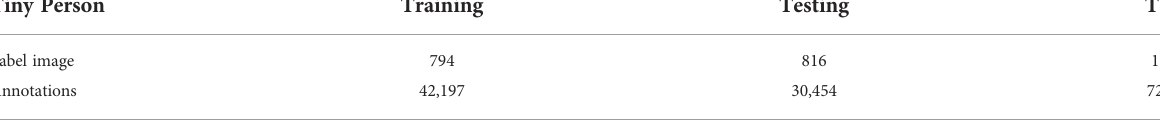
TABLE 1 Details of